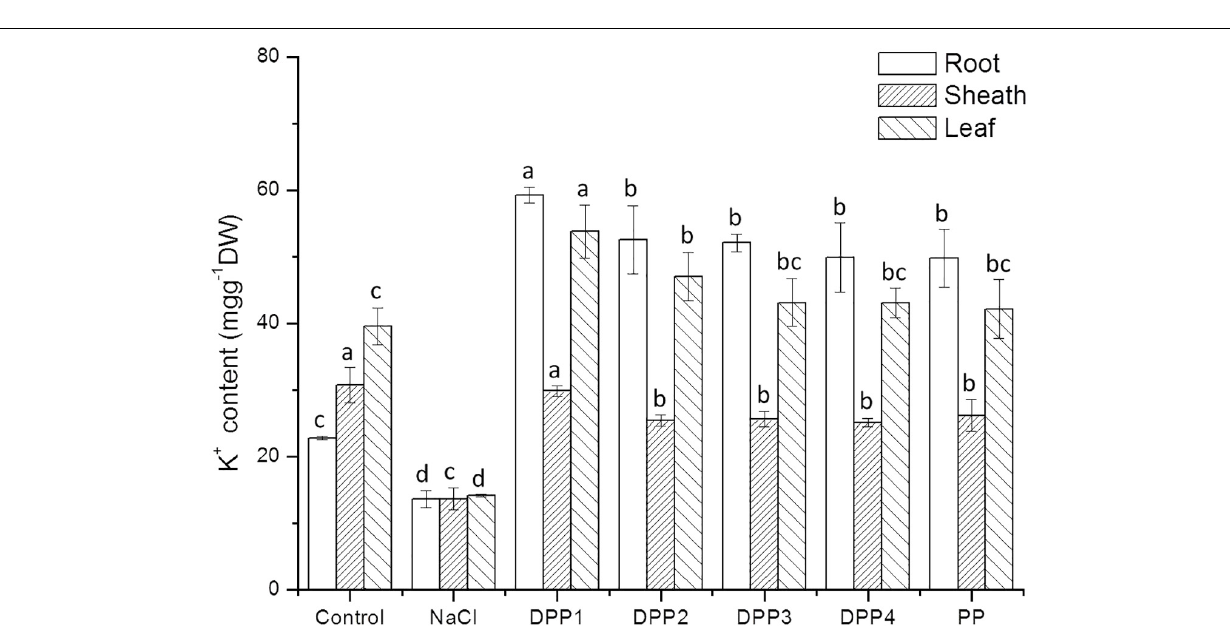
salt stress induced higher transcript levels of the TaSOS1 gene ( Figure 11 ). While treated with PPs, the expression of TaSOS1 was up regulated significantly in the root, sheath, and leaf ( Figure 11 ). Moreover, the transcript levels of TaSOS1 treated with DPP1 were significantly higher than those of the other groups ( P <